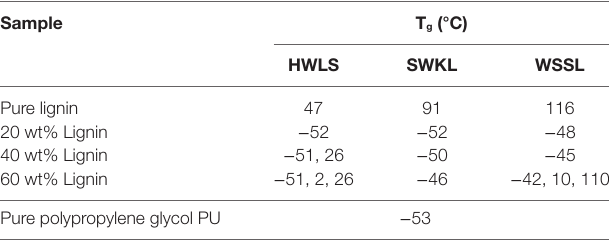
TaBle 1 | T g values obtained from differential scanning calorimeter scans of lignin-based polyurethane samples of 20, 40, and 60 wt%